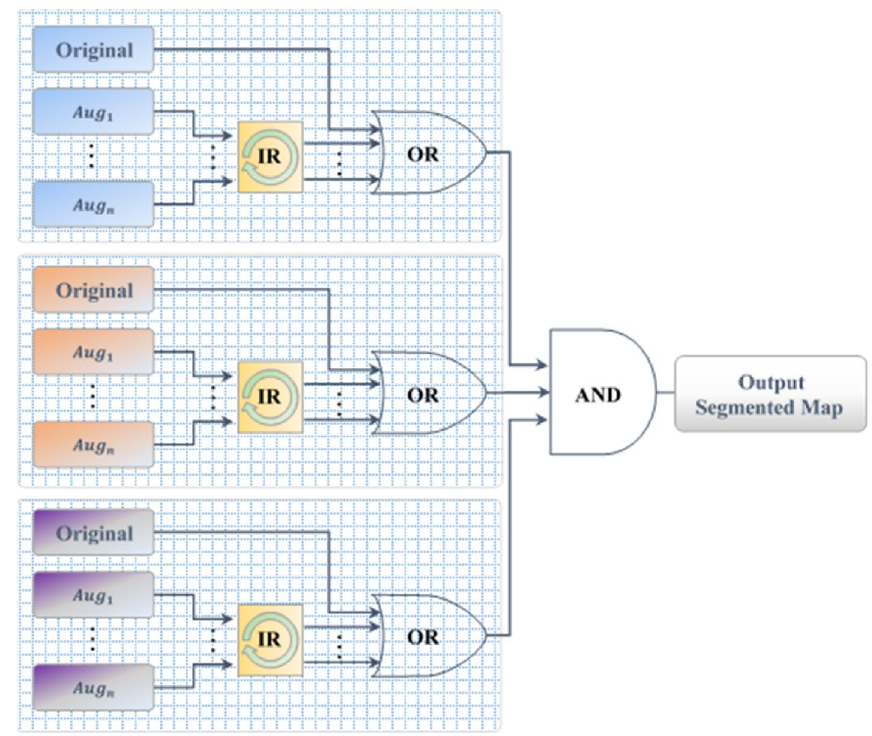
Figure 4. Inversion recovery evaluation